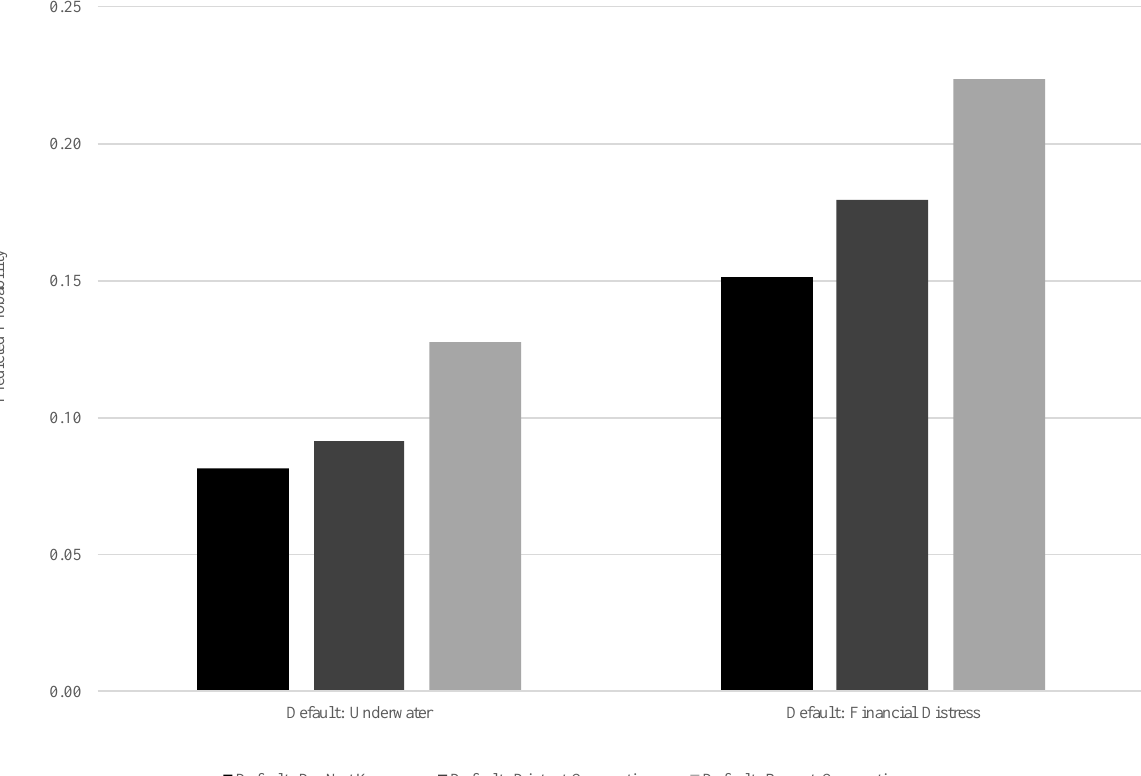
Figure 3: Predicted probabilities for attitudes toward default behavior by exposure to mortgage default. Notes :